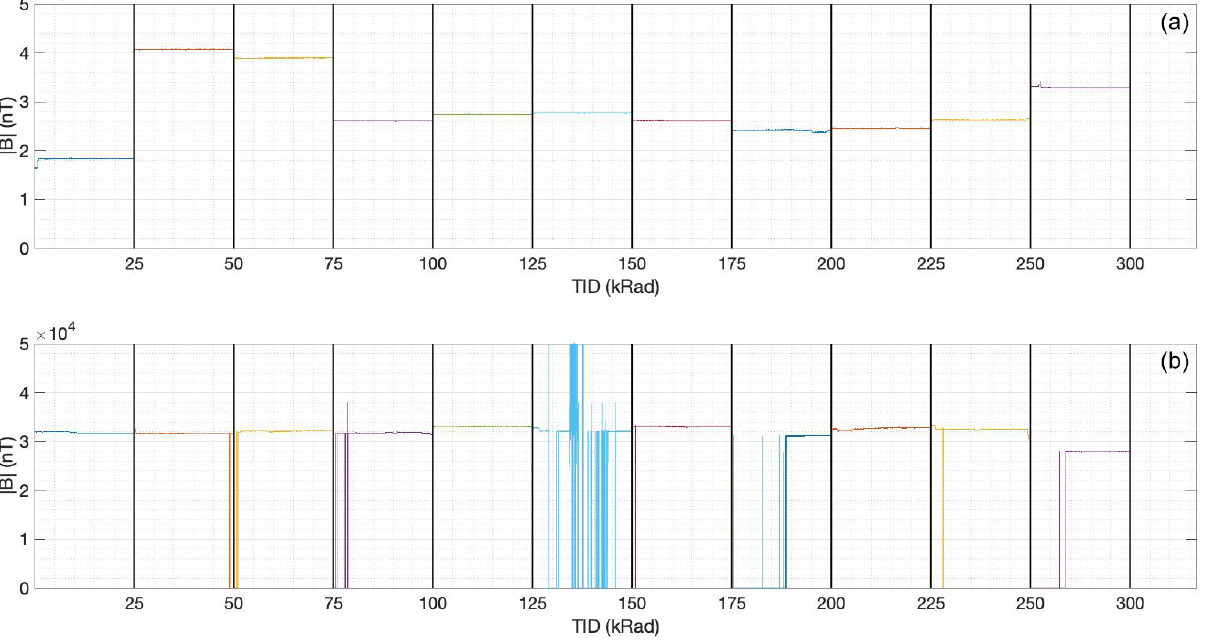
Figure 7. Magnitude of the magnetic field as measured by sensors 4 (a) and 5 (b) during the test campaign at the GSFC. The data shown between vertical lines correspond to 2min intervals collected between exposures. The vertical lines mark the TID that the sensors went through before taking the